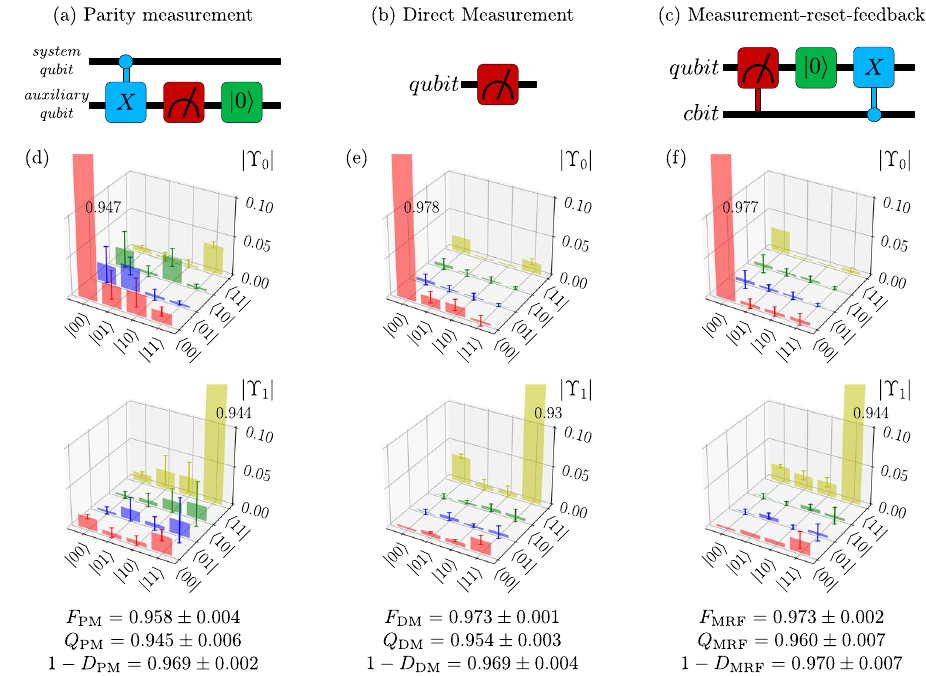
Fig. 5 Experimental QND-MT characterization of generalized measurements. Circuits depicting a a single-qubit parity measurement via an auxiliary qubit, b a direct qubit measurement, and c a measurement-and-reset scheme with classical feedback. d – f Choi matrices and quanti fi ers corresponding to each scheme. Error bars are the standard deviation estimated from 5 realization of the